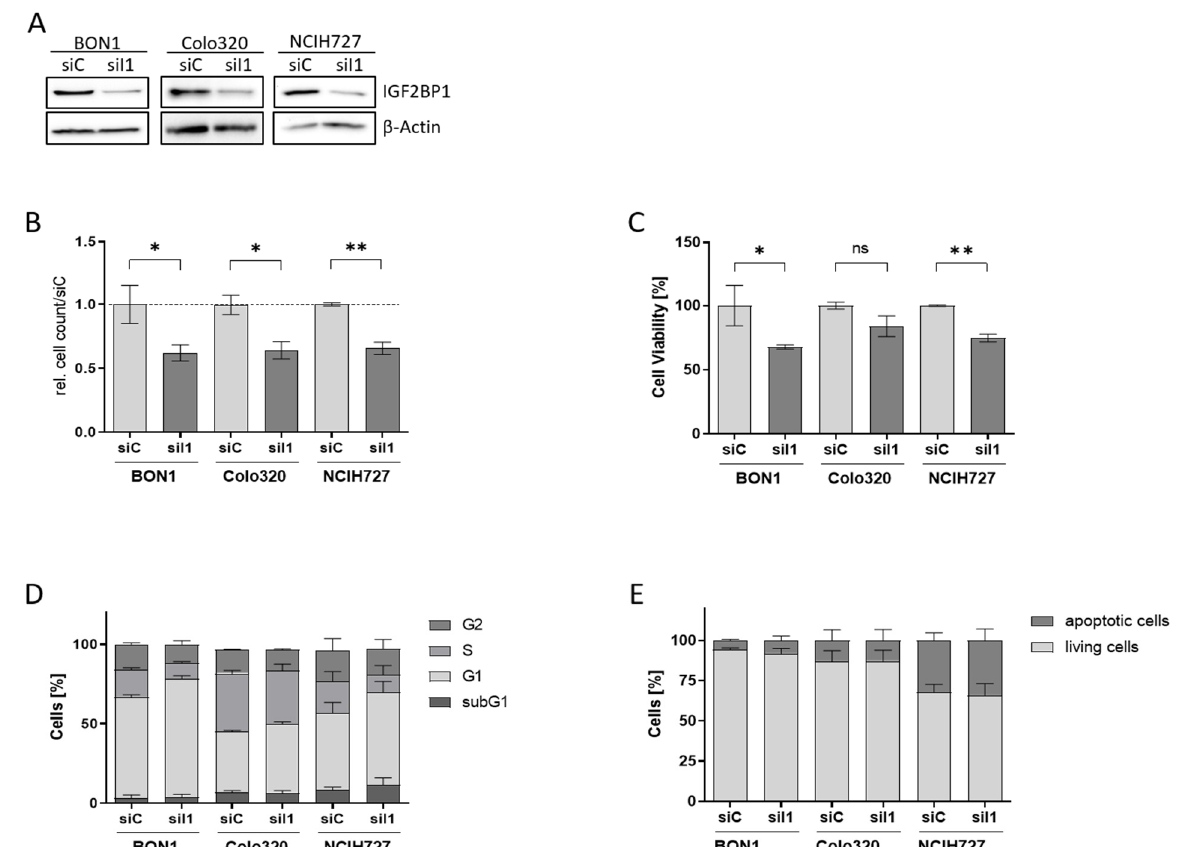
Figure 2. Knock-down of IGF2BP1 results in reduced proliferation and cell cycle progression in NEN cell lines. ( A ) Western blots of IGF2BP1 knockdown (siI1) in indicated NEN cell lines after 72 h.